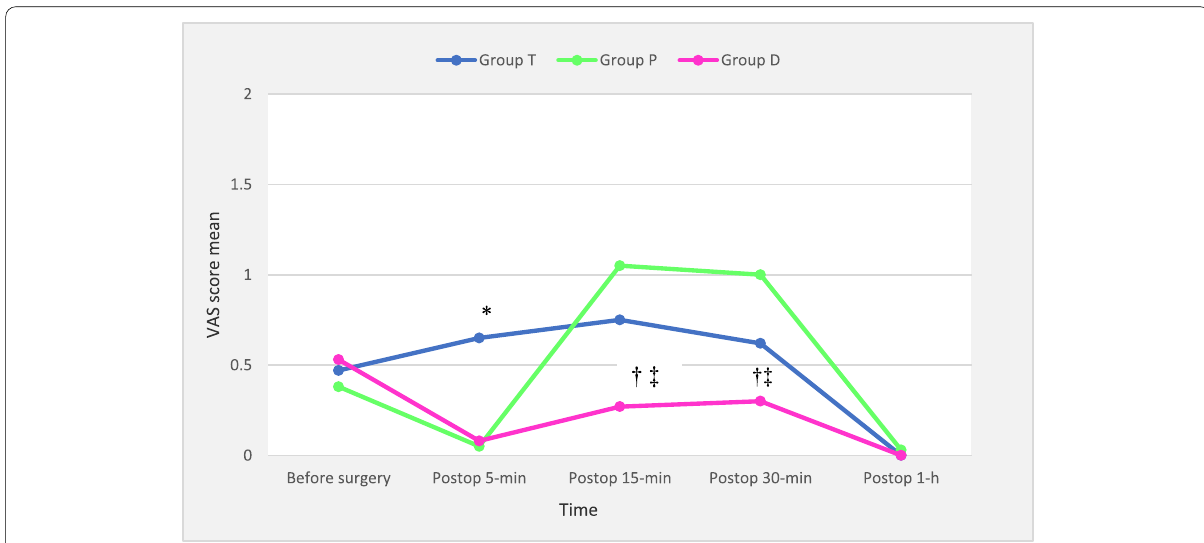
Fig. 2 Graphical presentation of the VAS (visual analog scale) values of the groups. Data are mean (SD), * p <0,05 refers to between groups comparisons. † p <0,05 refers to comparison between group T and group D, ‡ p <0,05 refers to comparison between group P and group D. VAS, vizuel analog scale; postop, postoperative; T, tramadol group; P, paracetamol group; D, dexketoprofen trometamol group; min, minute; h,